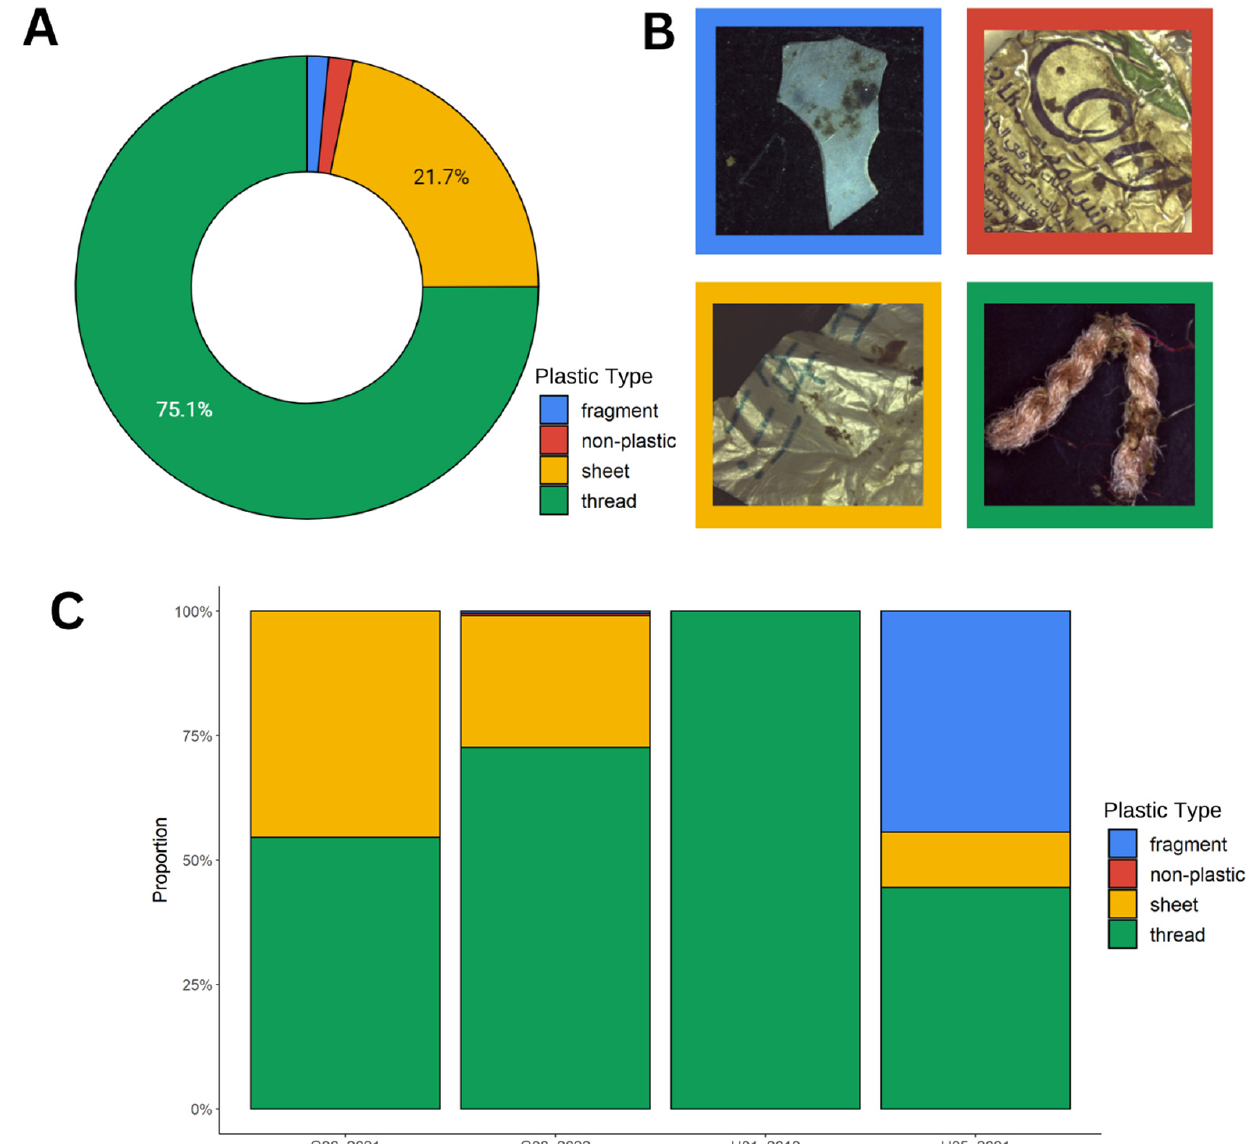
Figure 2. ( A ) The proportion of plastic categories found by mass in the digestive tracts of the turtles in the Saudi Arabian Red Sea. Plastic categories followed the INDICIT protocol, which includes (1) fragments (e.g., hard plastics), (2) non-plastic items (e.g., metal or foil), (3) sheet-like plastics (e.g., plastic bags), (4) thread-like plastics (e.g., nylon lines or ropes), or (5) foams (e.g., polystyrene foam). ( B ) Photographs depicting examples of each type of plastic found in the gastrointestinal contents of the turtles in this study. ( C ) The proportion of each plastic type found in the digestive tracts of the four deceased sea turtles.